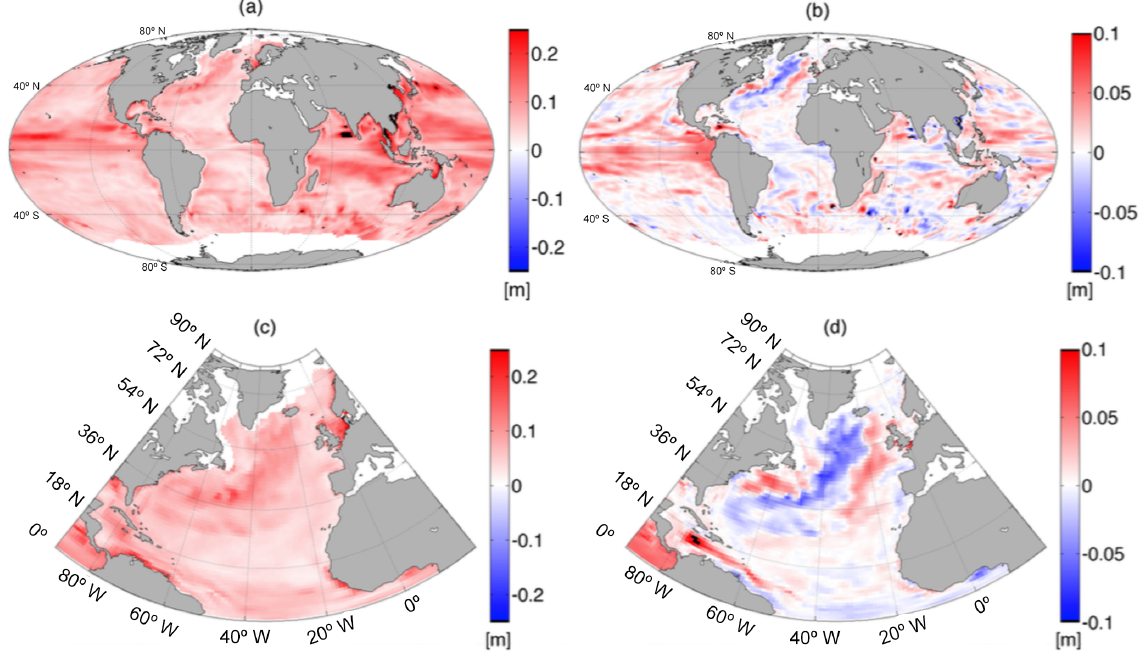
Figure 11. Extreme DSL values in meters for a 10-year return time of simulation R low differences between the period 2081–2100 and 2001–2020. All signals with frequencies lower than 550 days have been filtered out. The panels (c) and (d) are magnifications of (a) and (b) for the North Atlantic